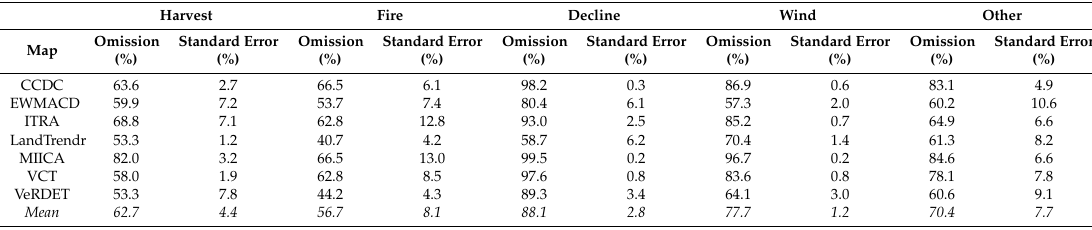
Table 3. Map omission by TimeSync disturbance causal agent class.